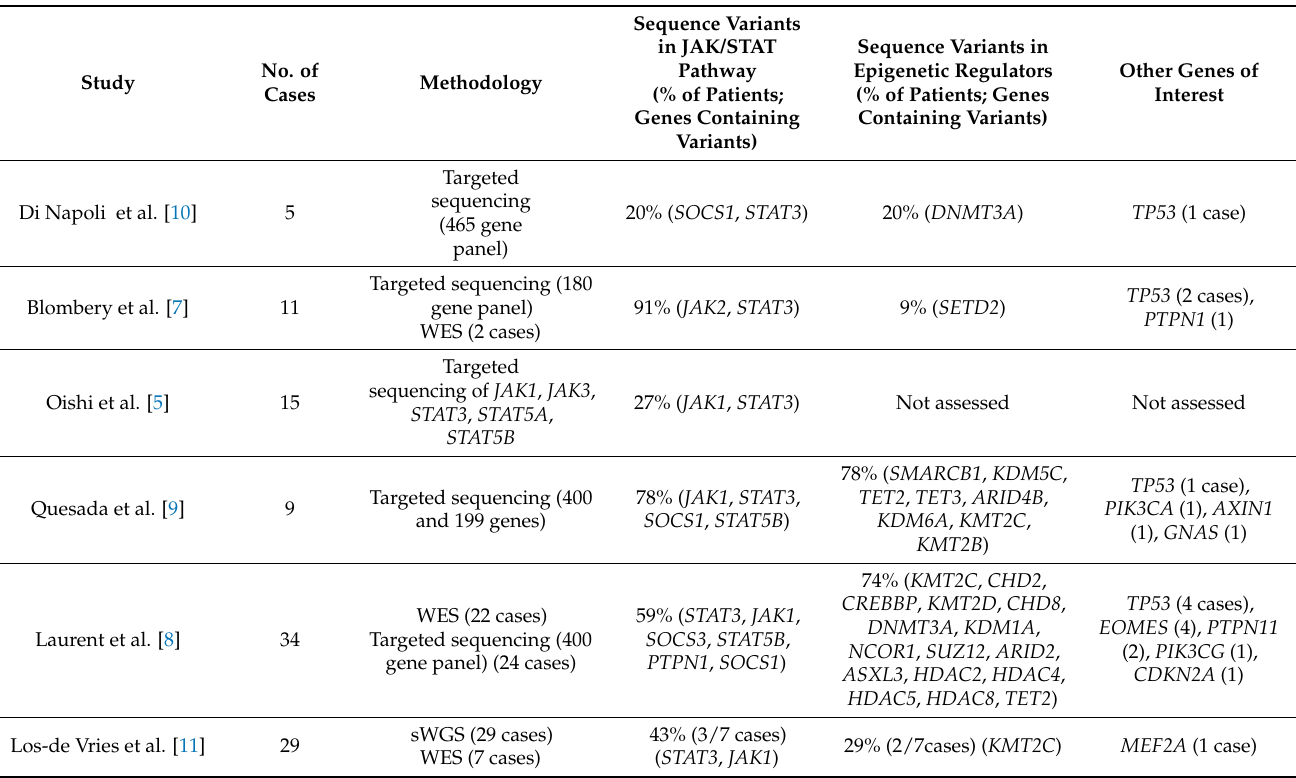
Table 1. Summary of key sequence variants reported in BIA-ALCL